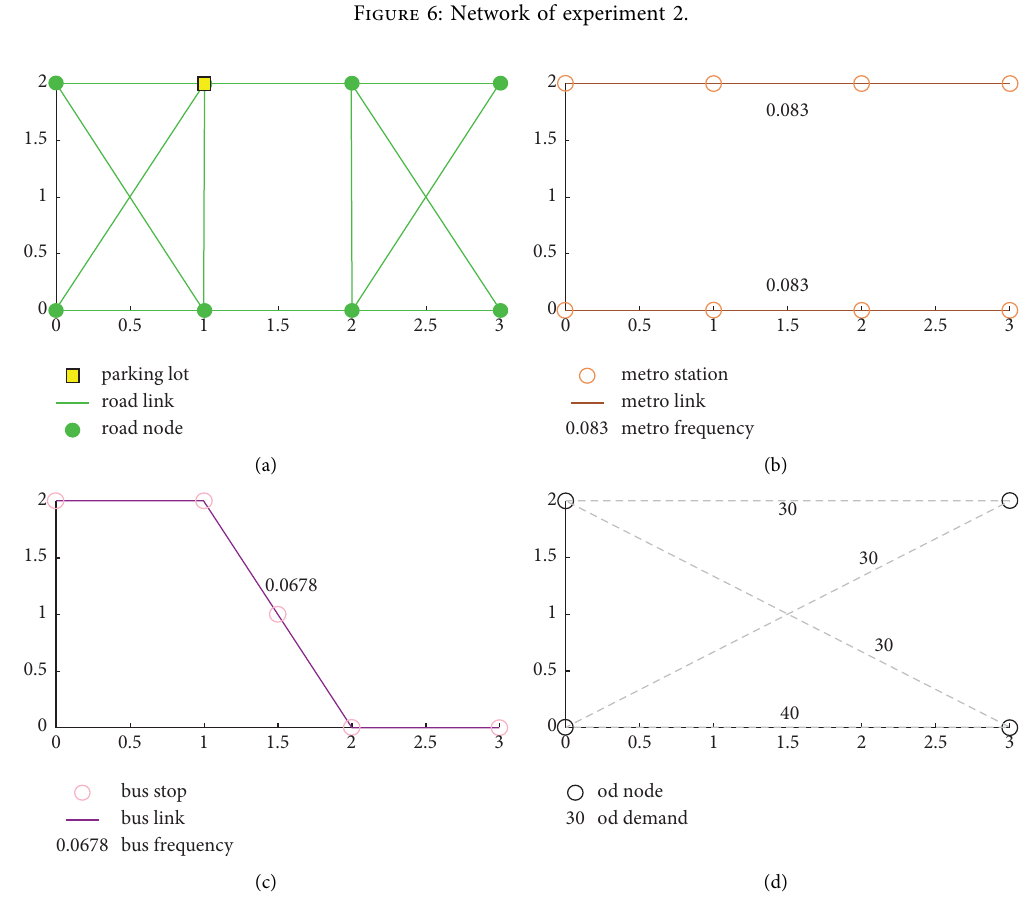
Figure 7: Coordinates of experiment 2 subnetworks.